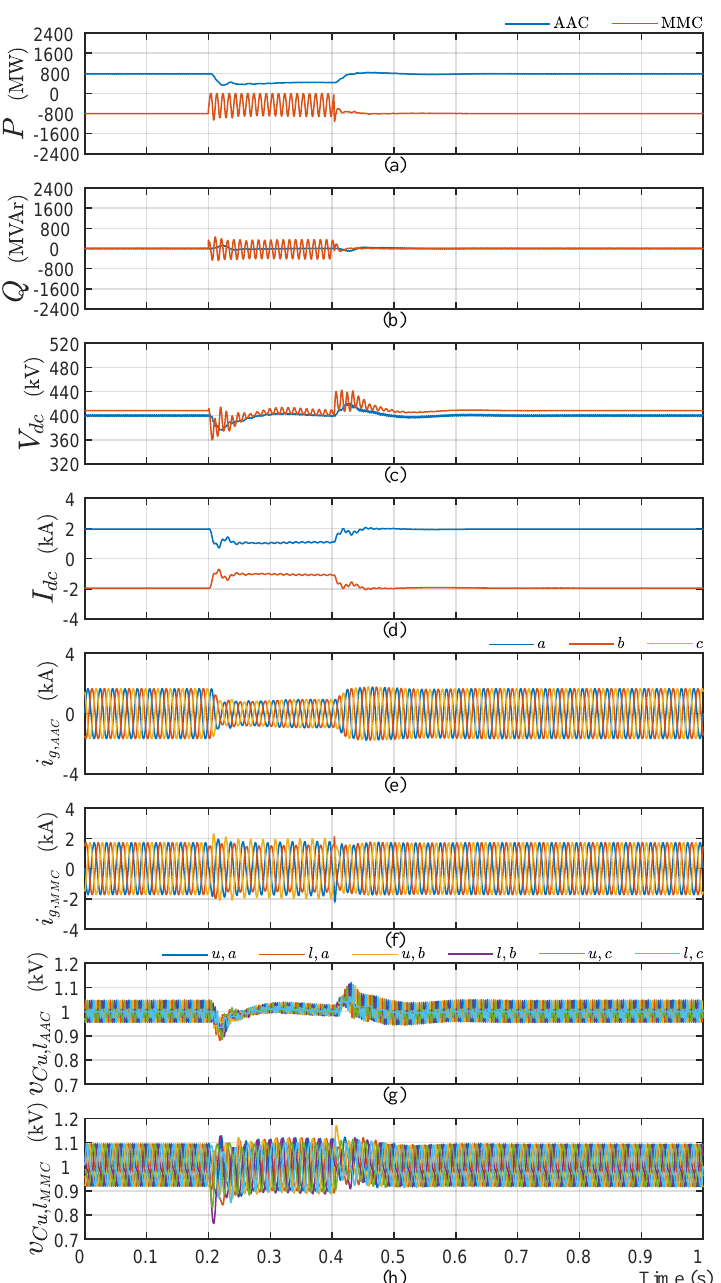
Figure 11. MMC phase-to-phase fault at 0.2 s: ( a ) active power, ( b ) reactive power, ( c ) dc-voltage, ( d ) dc-current, ( e ) ac currents of AAC, ( f ) ac currents of MMC, ( g ) SM capacitor voltages of AAC, and ( h ) SM capacitor voltages of